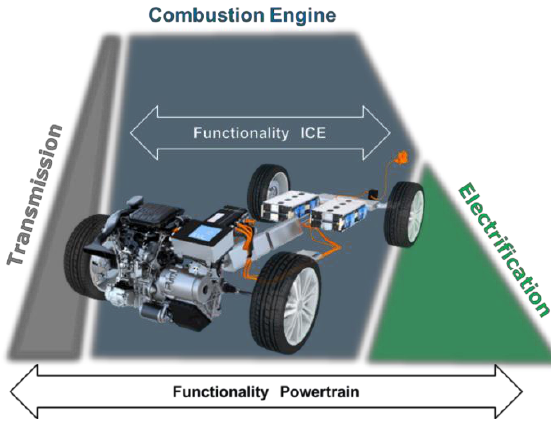
Fig. 6. From "Fully Flexible Combustion Engine" to "Fully Flexible Powertrain" [1]